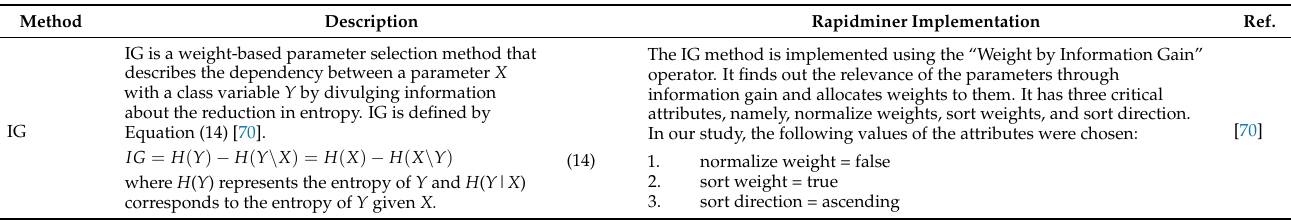
Table 8. Description of the parameter selection